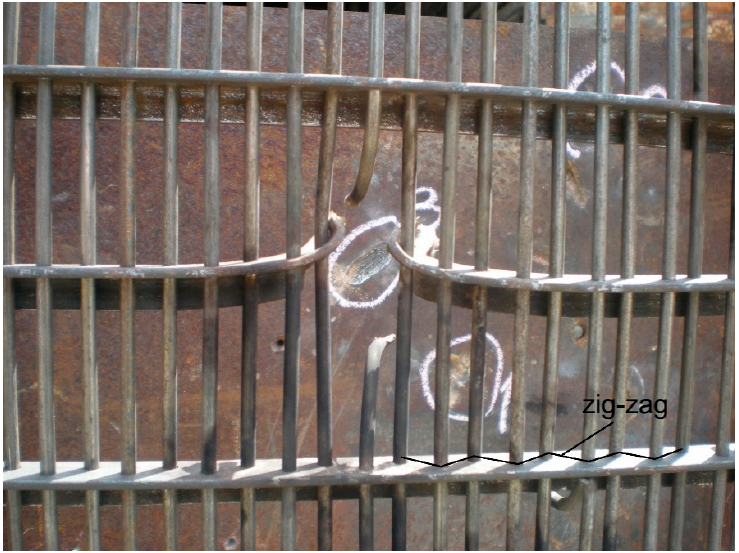
Figure 2. Patented wires in a zig-zagged configuration useful in causing projectile yaw. Zig-zag configuration of patented wires is indicated by a broken black line [15].